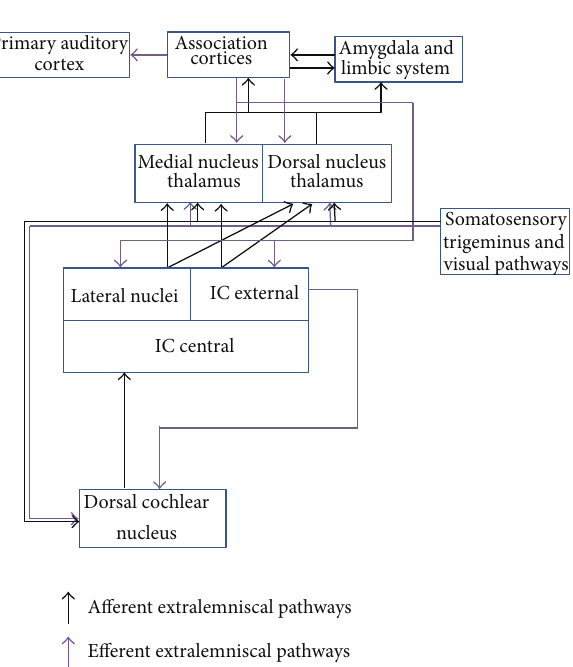
Figure 2: Extralemniscal pathways, modified from [34]. Abbrevia- tions: IC = Inferior